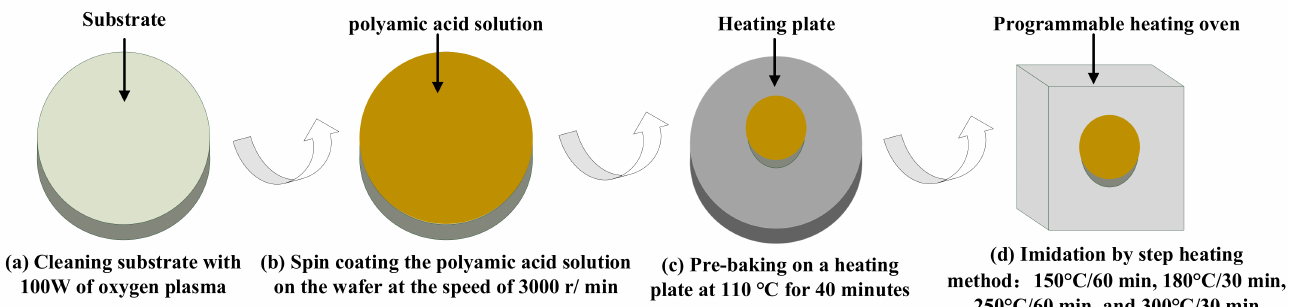
Figure 3. Preparation procedures of PI film, including: ( a ) substrate cleaning; ( b ) spin coating polyamide acid solution; ( c ) pre-baking; ( d ) imidation by step heating method.